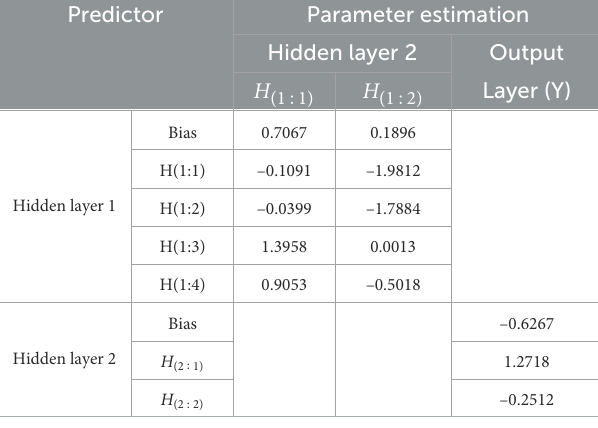
TABLE 10 Iteration summary for training and testing